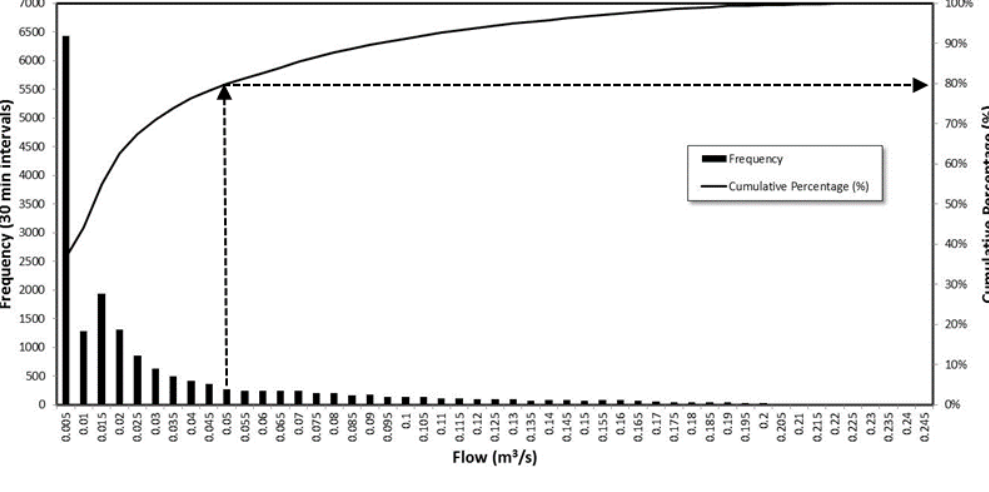
Figure 15. Histogram of flow in the main line.